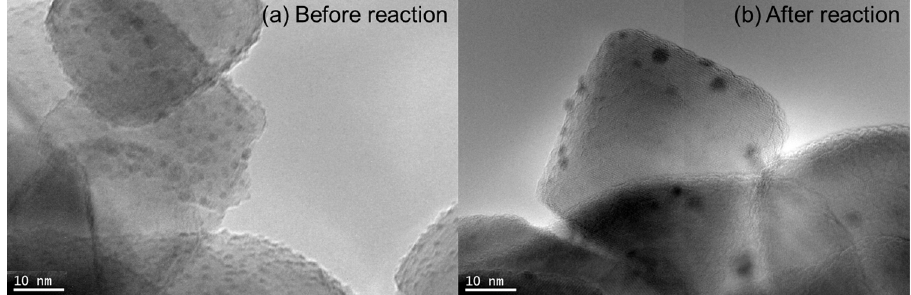
Figure 3. Transmission electron microscopy (TEM) images of 5% Pd / TiO 2 (Cat. D , anatase-type) before ( a ) and after ( b ) the Suzuki–Miyaura coupling reaction.